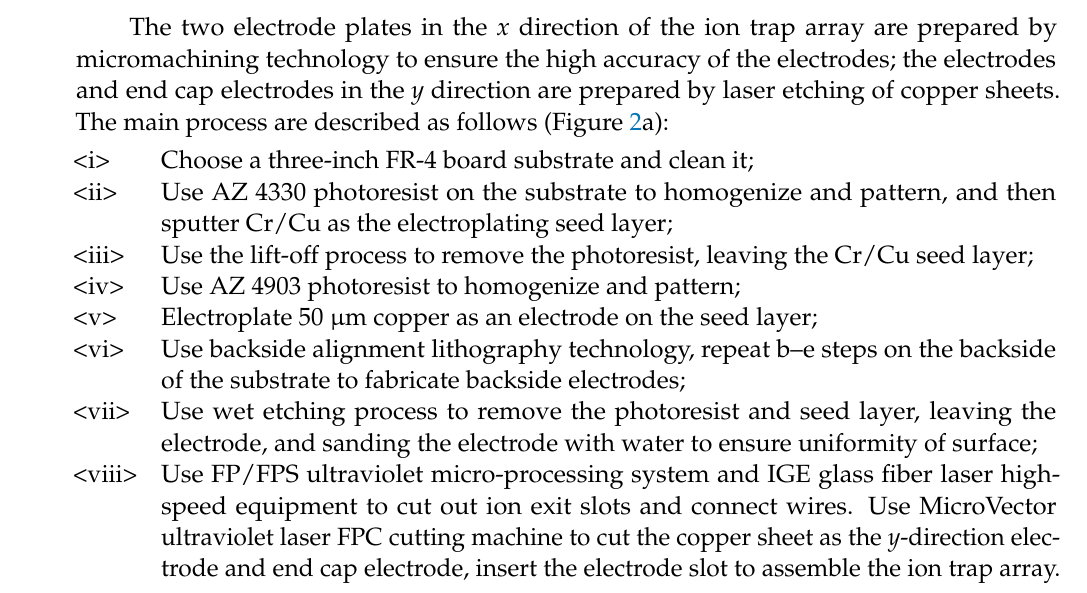
Figure 1. Structure diagram of MFITA.